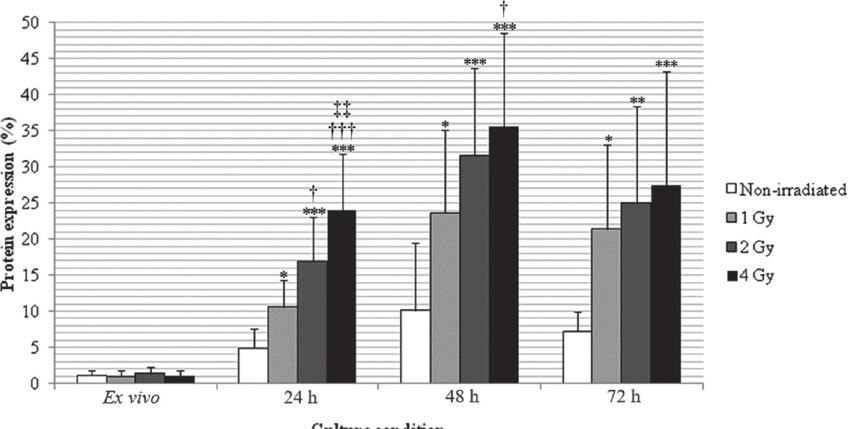
Figure 2 - Expression level of active caspase-3 on lymphocytes through time, for ex vivo or in vitro protocols. Bars show mean ± SD. Symbols: *, for comparison with control group, † for comparison with 1 Gy-irradiated, and ‡ for comparison with 2 Gy-irradiated. One symbol: p ≤ 0.05; two symbols: p ≤ 0.01; three symbols: p ≤